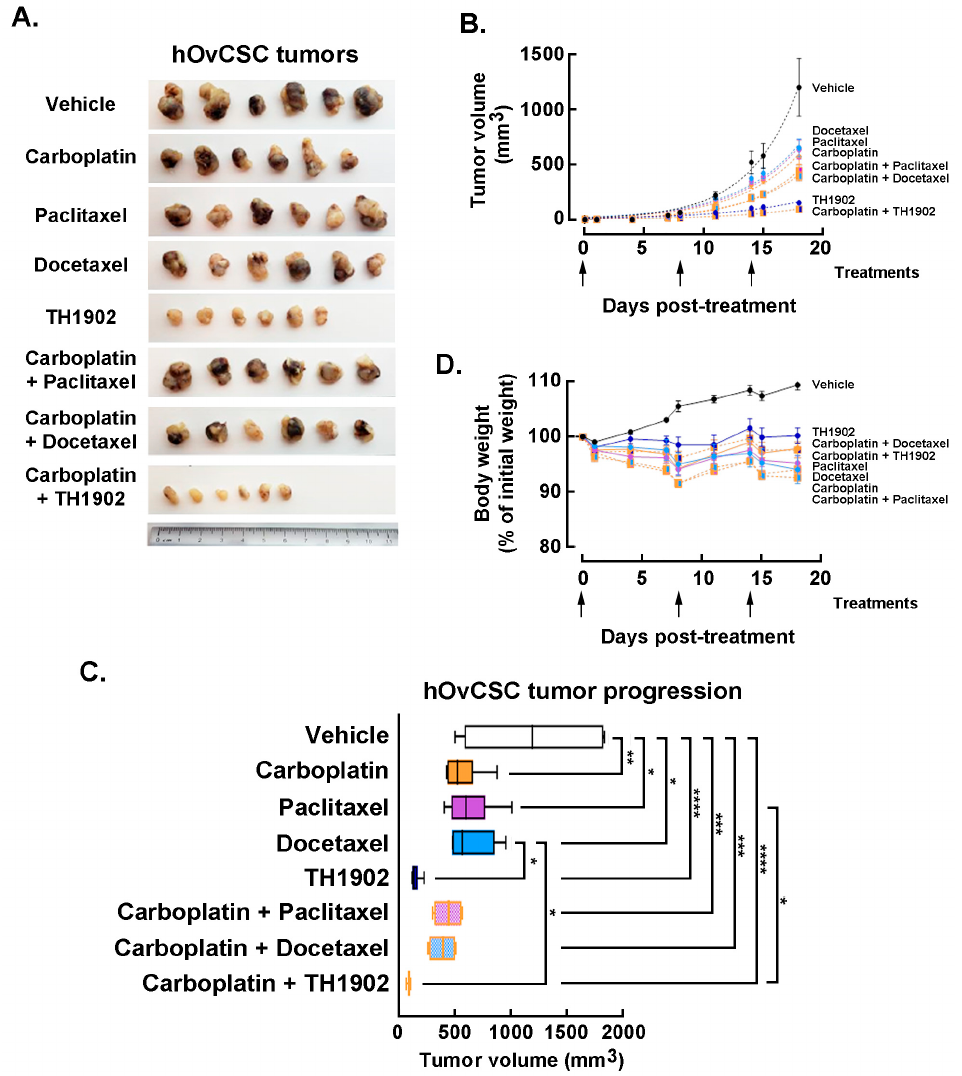
Figure 7. Growth of hOvCSC xenografts within mice following single agents or combination ad- ministration of TH1902, paclitaxel, or docetaxel to TH1902 . ( A ) Mice bearing hOvCSC xenografts were treated with either single articles (40 mg/kg/week carboplatin, 10 mg/kg/week paclitaxel, 10 mg/kg/week docetaxel or 23 mg/kg/week TH1902) or with the single taxanes or TH1902 combined with carboplatin. Following euthanasia, tumors were excised from the mice, fixed and then photographed. The ruler shown at the bottom for scale is numbered in centimeters. ( B ) Groups of mice bearing hOvCSC xenografts were administered IV Vehicle, docetaxel, TH1902 or paclitaxel with and without IP injection of carboplatin. The arrows shown beneath the abscissa indicate the days at which all treatments were administered. Symbols represent means ± SEM, n = 6 for all groups. The dotted lines joining each set of points are exponential curves calculated to best fit each group. ( C ) Tumor sizes on day 18 (final day of experiment) were measured for all animals and these sizes were compared between the groups receiving different treatments. The box ends represent the median values of the lower and upper halves of the datasets and the whiskers show the minimum and maxi- mum values of each set. The vertical line inside the box marks the median value for that set. Pairwise comparisons that are not marked in the figure were not statistically significant. Statistical compari- son was performed using a one-way ANOVA followed by Tukey’s multiple comparisons test with statistical significance pre-set at p < 0.05. * denotes p < 0.05, ** denotes p < 0.01, *** denotes p < 0.001 and **** denotes p < 0.0001. n = 6 for all groups. ( D ) Groups of mice bearing hOvCSC xenografts were treated with either vehicle or with carboplatin, docetaxel, TH1902 or paclitaxel, or